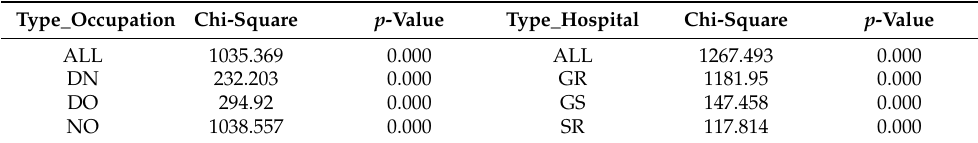
Table 5. Chi-square test of infection rate variables in different types of medical